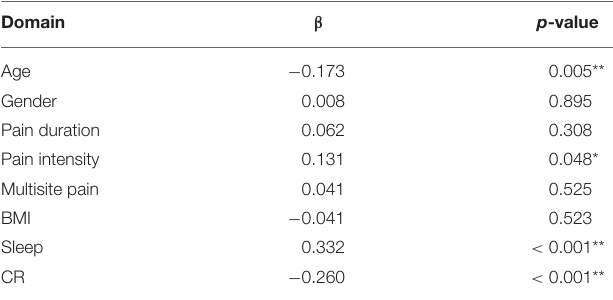
TABLE 4 | Multiple regressions: the influence of chronic pain and psychosocial factors on mental health. Domain β p